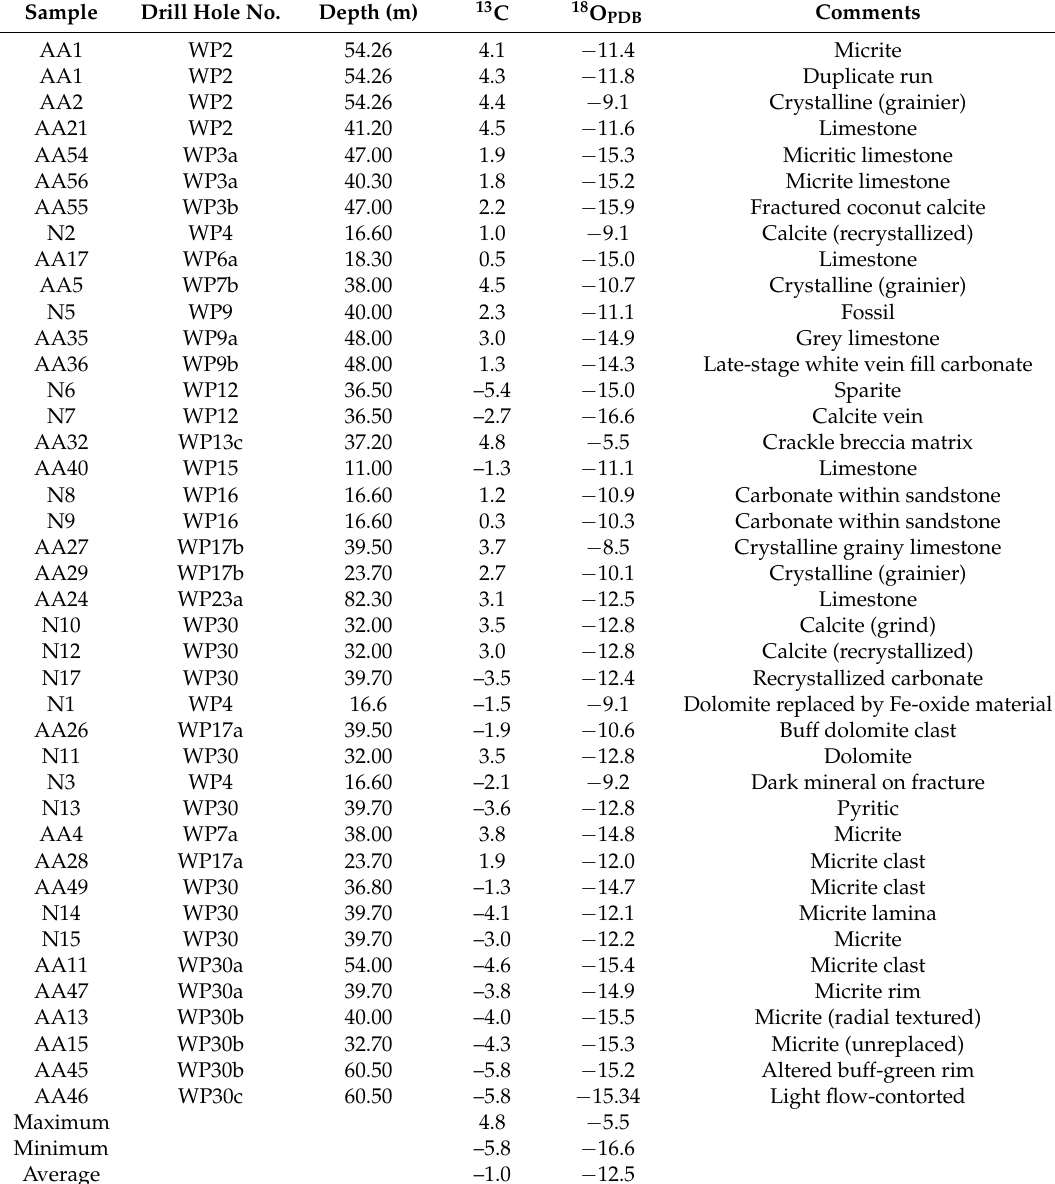
Table 2. Stable carbon and oxygen isotope values of carbonate laminae and clasts within the gypsum–anhydrite beds and associated carbonate rocks from the exploration wells, Wang Saphung area, Loei Province,